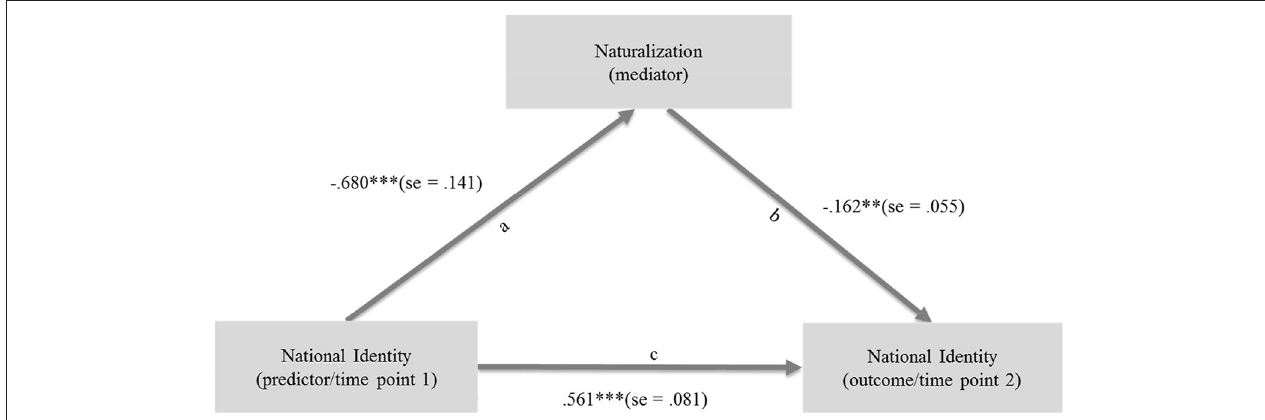
FIGURE 2 | National identity 1 predicted National Identity 2 via Naturalization (categorical: naturalized [0] vs. non-naturalized [1]), unstandardized regressions weights. Indirect effect: 0.110; se = 0.046, z = 2.379; p = < 0.05; 95% confidence interval: [0.041, 0.218]. *** p < 0.001, ** p < 0.01.